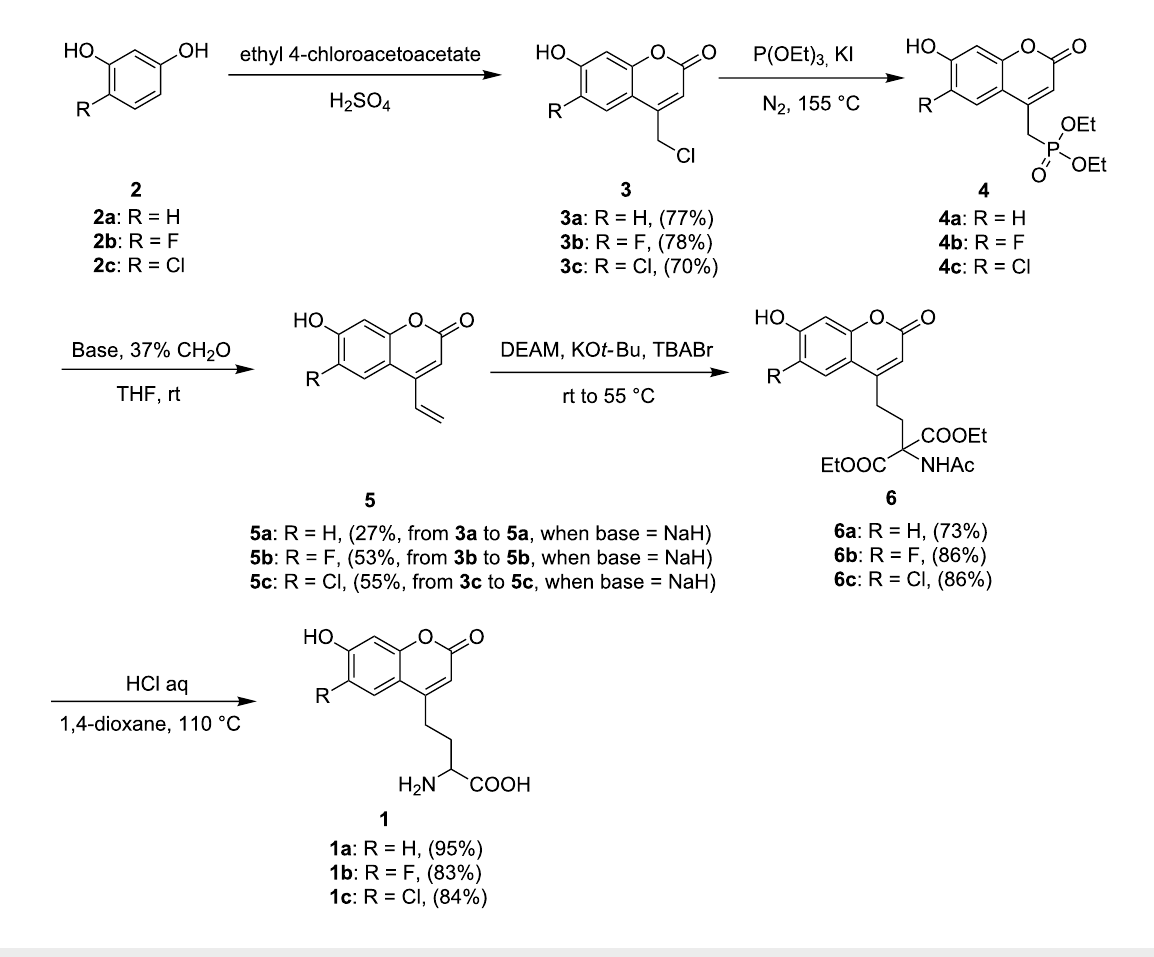
Scheme 1: Synthetic route to fluorescent amino acids 1a , 1b and 1c .